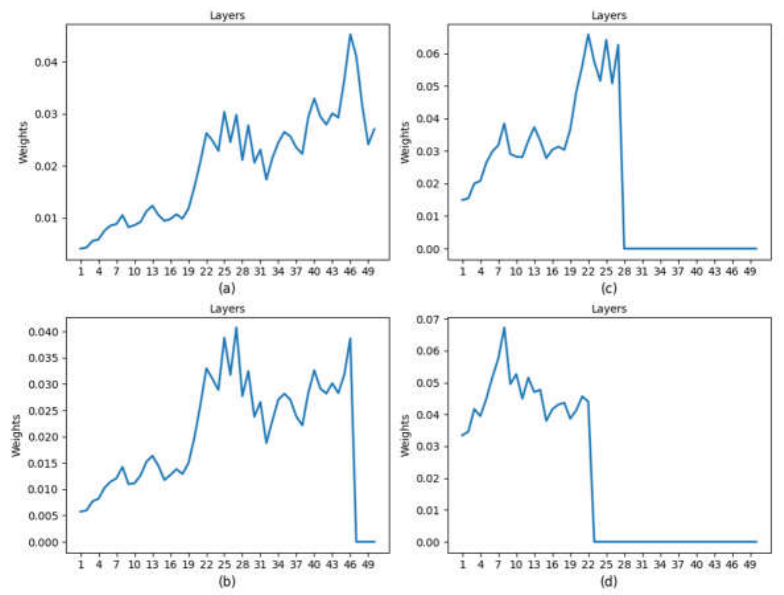
Figure 8. Layer relevance weights learned by the proposed class-independent ANNA on MNIST dataset after training the model using: ( a ) 1 batch; ( b ) 4 batches; ( c ) 6 batches; ( d ) 15 batches.